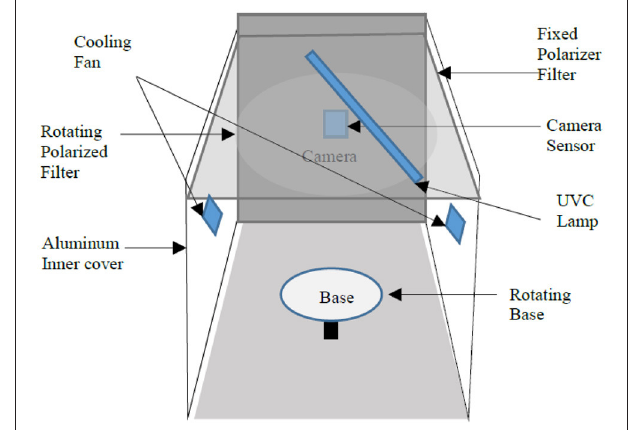
FIGURE 1 | Top view of the UVC device.